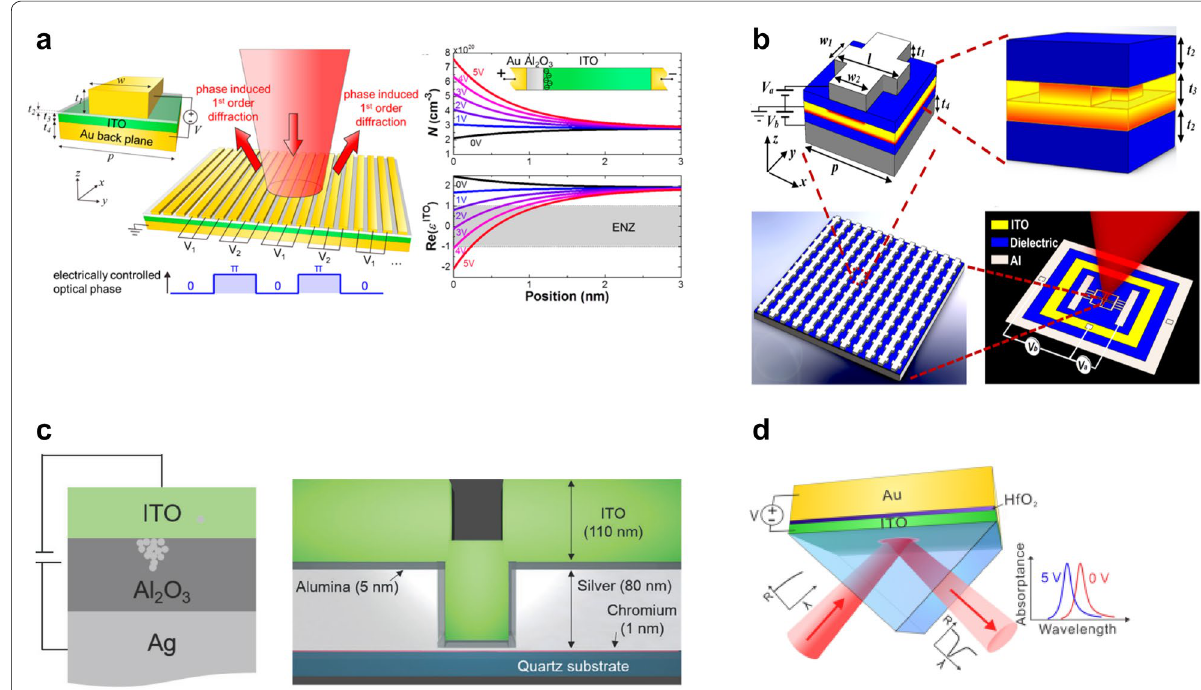
Fig. 1 Tunable meta‑atoms with transparent conducting oxides. a An ITO layer under external bias modulates the charge accumulation region near ENZ dispersion condition, resulting in a phase shift for the reflected light in the SWIR region [51]. Reproduced with permission from ©2016, American Chemical Society. b Dual gated ITO layer for enhanced phase shift up to 303 ° at 1550 nm [52]. Reproduced with permission from ©2018, American Chemical Society. c Ionic‑conduction‑induced visible tunable meta‑atom [40]. Reproduced with permission from ©2017, Wiley–VCH. d Oxide heterostructure for Berreman dispersion mode [53]. Reproduced with permission from ©2018, American Chemical